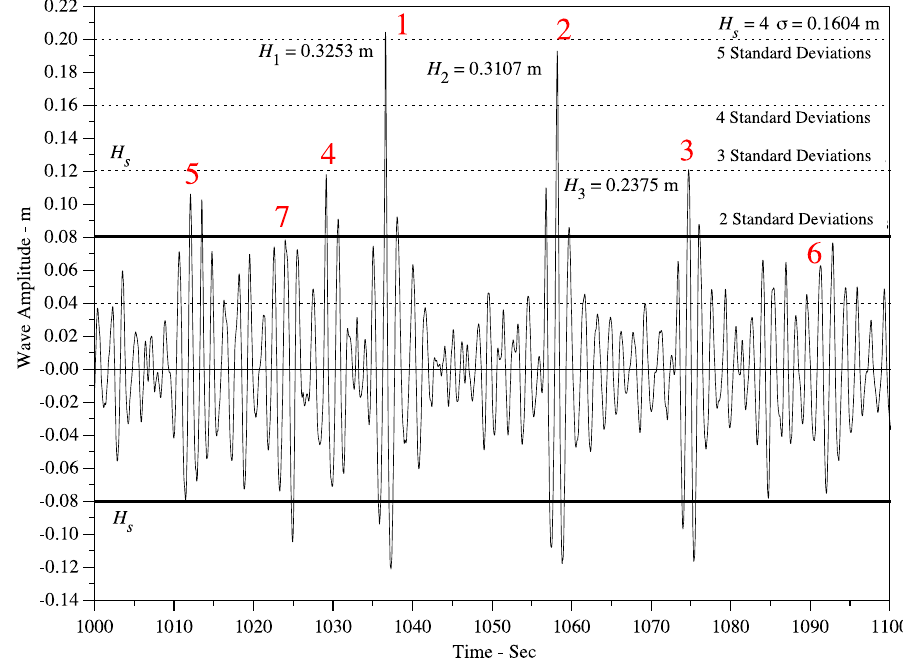
Figure 26. A 4096 ‐ point time series from probe 8 at 70 m from the wave maker in the experiments of Figure 25. Three extreme waves have amplitudes that are greater than three standard deviations. The largest packets (associated with their NLFA components, see Figure 20) are indicated by red numbers. The largest packet is greater than twice the significant wave height.